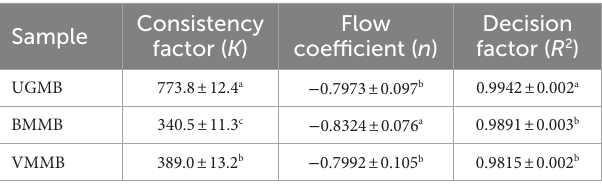
TABLE 4 Mung bean powder rheological parameters.